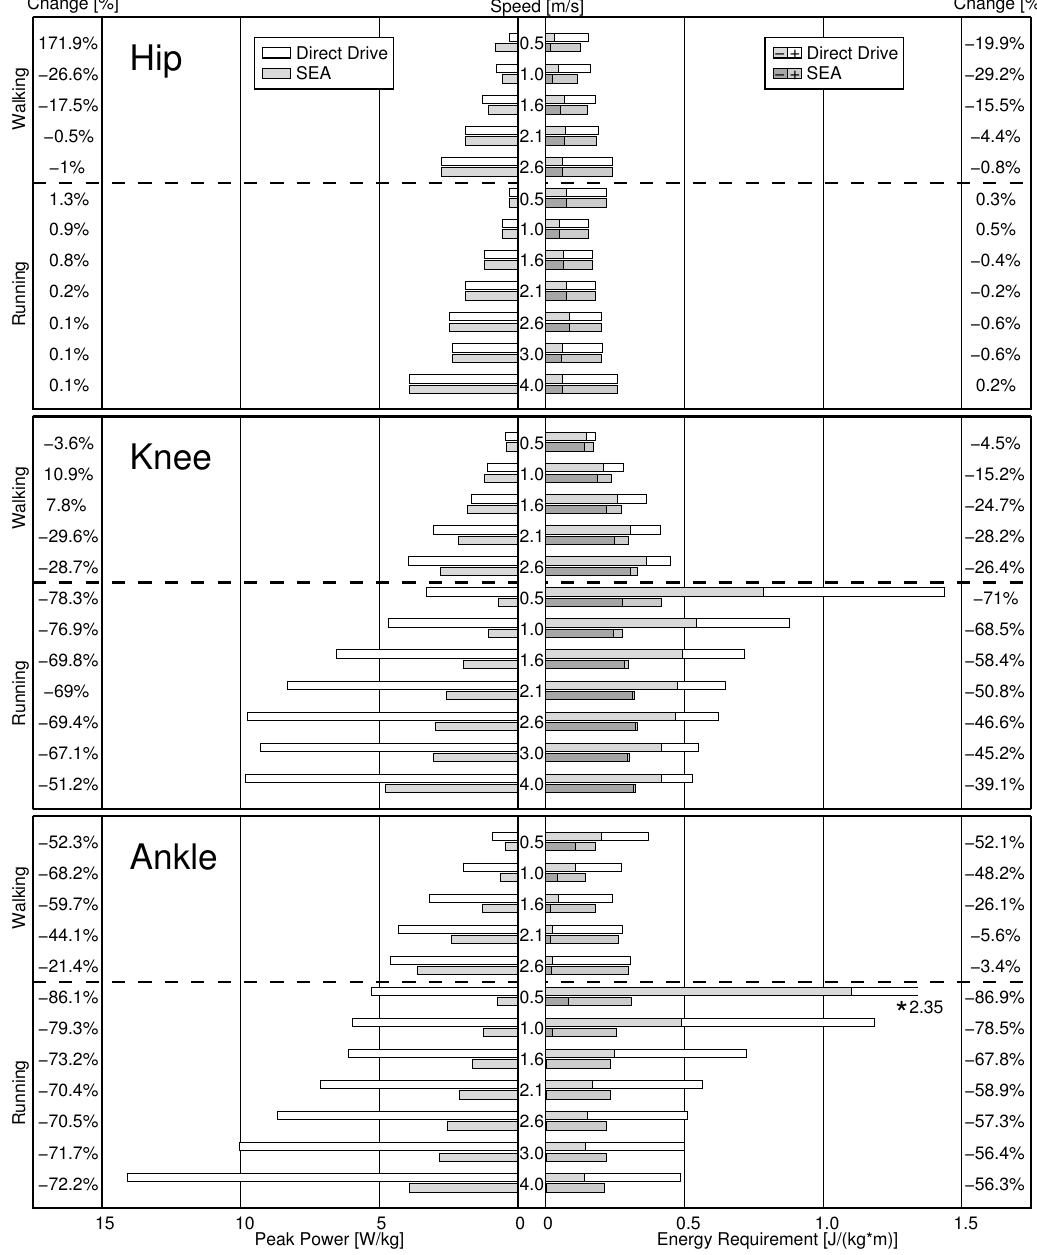
Figure 3. Hip, knee and ankle joint peak power ( left side) and energy requirements ( right side) for different walking and running speeds for SEAs and direct drives. SEA spring stiffness was optimized to minimize energy requirements at the hip and the knee. At the ankle, spring stiffness was optimized to minimize peak power. The amount of negative work is shown as the darker parts of the energy requirement bars, and the amount of positive work is shown as the lighter parts of the energy requirement bars. The outer columns list the difference in energy and peak power requirements between the SEA and the direct drive (SEA/DD · 100; in percent). The middle column lists the corresponding walking or running